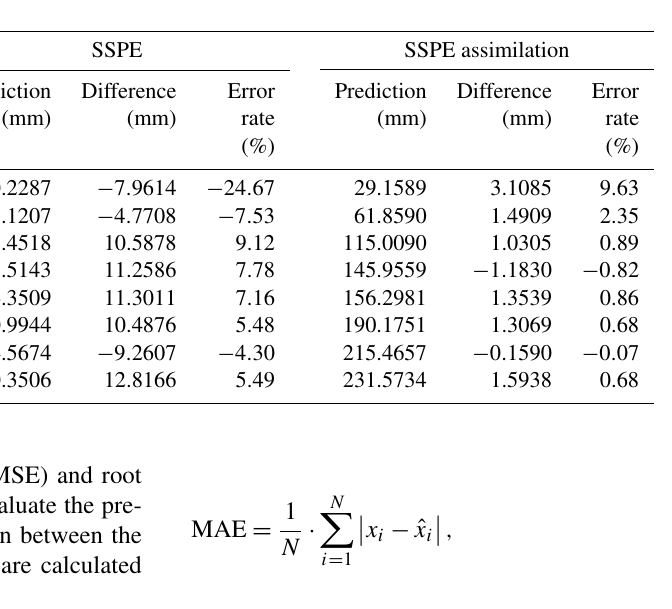
Figure 7. The periodic-term displacement prediction of (a) station GPS03 and (b) station GPS04. Table 1. Comparison between the predicted values of cumulative displacement and measured displacement using different methods in station